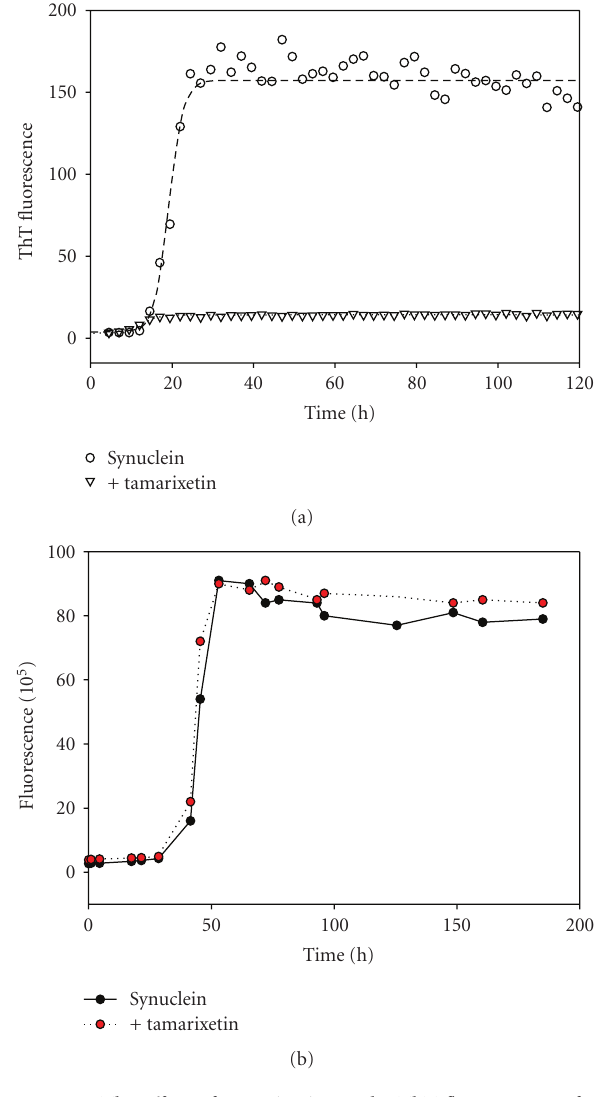
Figure 5: The e ff ect of tamarixetin on the ThT fluorescence of α - synuclein fibrillation by two ThT assays: the plate reader assay (a) and the manual assay (b).